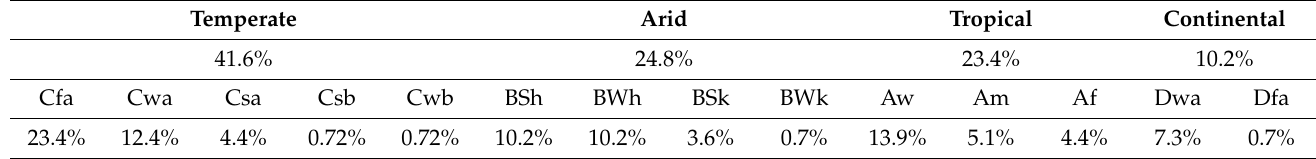
Table 1. Share of studies regarding the climate regions classified based on Köppen climate classification.